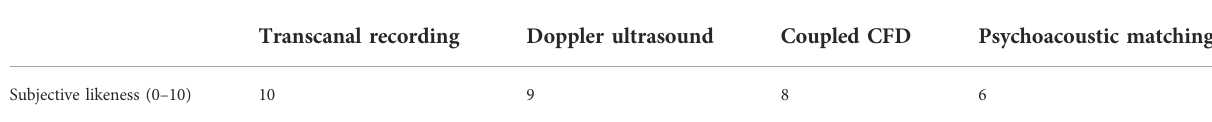
TABLE 4 Results of subjective likeness